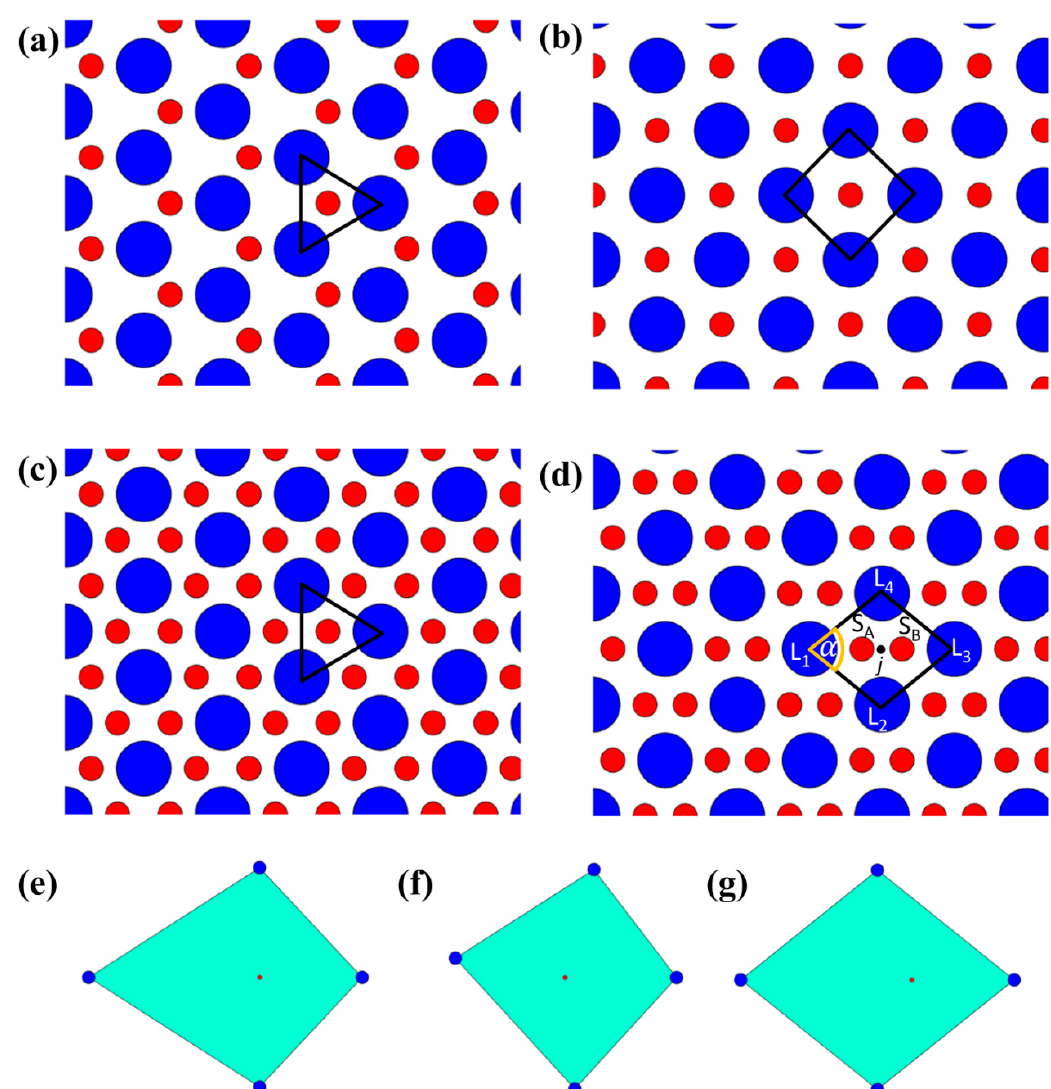
Figure 5. Configurations of L particles around S particles: ( a ) Isolated S particles present alternatively in the interstices between L particles arranged in a hexagonal pattern; ( b ) isolated S particles present in the interstices between L particles arranged in a square pattern; ( c ) isolated S particles present in all the interstices between L particles arranged in a hexagonal pattern; ( d ) S particle dimers present between L particles arranged in a rhombic pattern; ( e ) S particles surrounded by L particles with angularly uniform and radially non-uniform distribution; ( f ) S particles surrounded by L particles with angularly non-uniform and radially non-uniform distribution; ( g ) S particles surrounded by L particles with angularly non-uniform and radially non-uniform distribution.